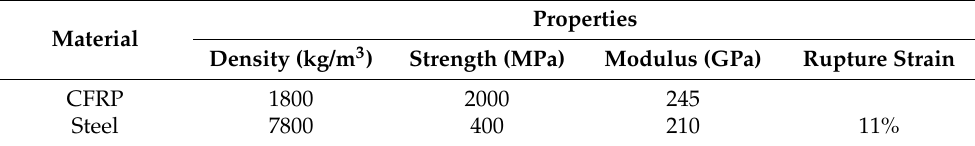
Table 1. Mechanical properties of CFRP and steel for the proposed composite